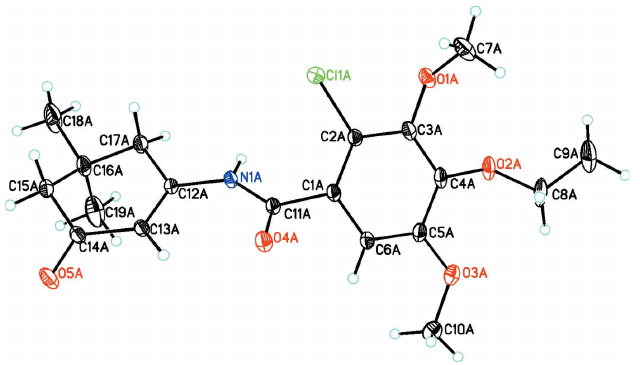
Figure 2 The molecular structure of 3ba with atom labeling and with atomic displacement parameters shown at the 30% probability